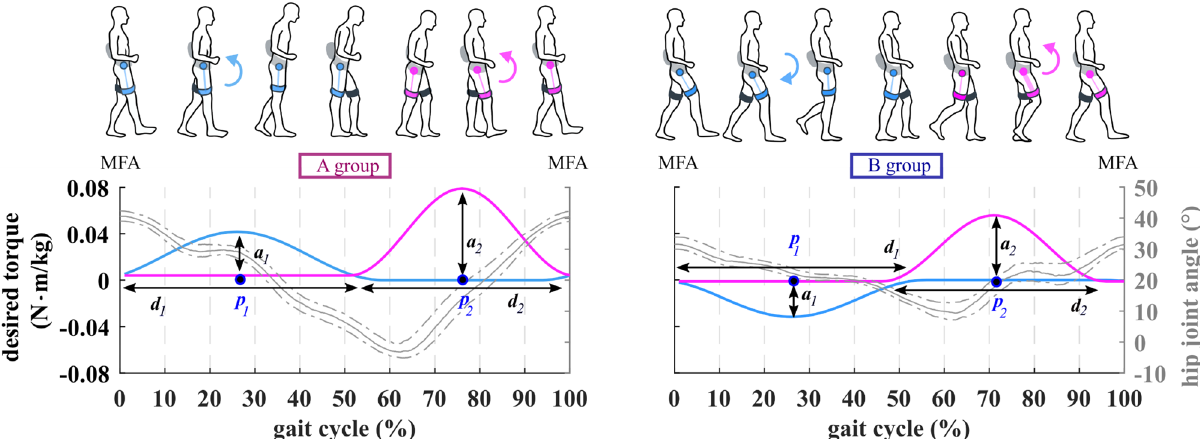
Figure 1. Impairment-specific hip assistance (iHA) adopted for the two study groups. On the left, a double flexion assistive profile adopted for group A (i.e. subjects with knee hyperextension). On the right, an extension- flexion assistive profile adopted for group B (i.e. subjects with deficits in hip flexion/extension). Paretic hip angle (grey), measured by the APO onboard sensors (medians and percentiles—25th, 75th), and desired assistive torque profiles for two representative subjects are depicted. The hip angle is segmented at the max flexion angle (MFA) and normalized to stride duration. The desired assistive torque is computed as the sum of two Gaussian functions (light blue, light purple). The first Gaussian curve occurs during stance, the second during swing. For each Gaussian function, the following parameters can be tuned: phase (p 1 and p 2 , i.e. % of the gait phase where the peak occurs), amplitude [a 1 and a 2 (N·m), i.e. amplitude of the Gaussian peak, which can be either positive (flexion) or negative (extension)] and duration of the assistance (d 1 and d 2 , i.e. the width of the Gaussian function in % of the gait